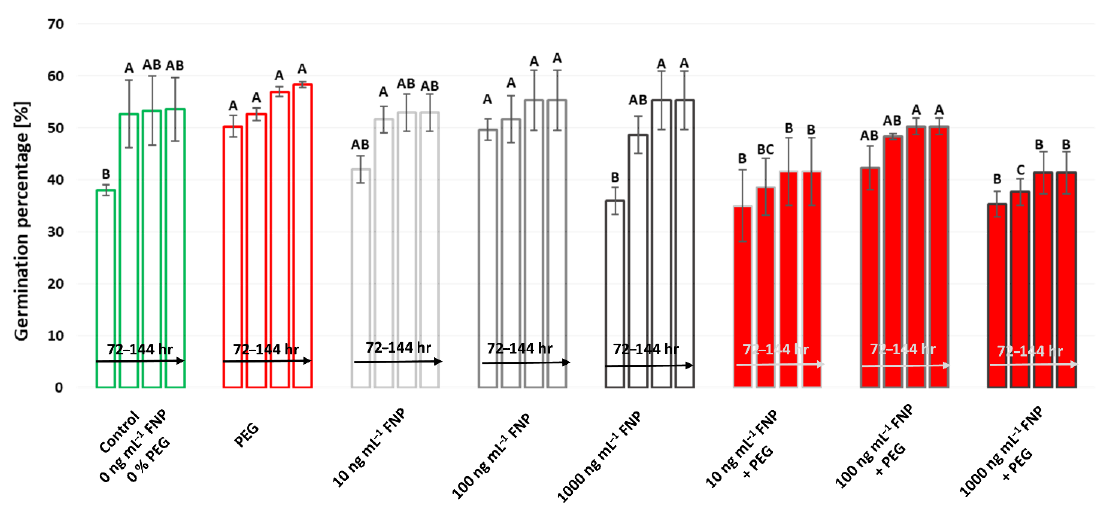
Figure 2. Germination percentage under drought (PEG), fullerol C 60 (OH) 24 nanoparticles (FNP; 10, 100 and 1000 ng mL − 1 ) and combined FNP–PEG treatments (10 ng mL − 1 FNP + PEG, 100 ng mL − 1 FNP + PEG, and 1000 ng mL − 1 FNP + PEG) during 72, 96, 120, and 144 h (from left – right ). Germination percentage is calculated for period of 72 to 144 h. Values are means ± S.D. ( n = 3). The different letters indicate statistically significant differences among the mean values of different treatments at p < 0.05 using Tukey’s post-hoc test.